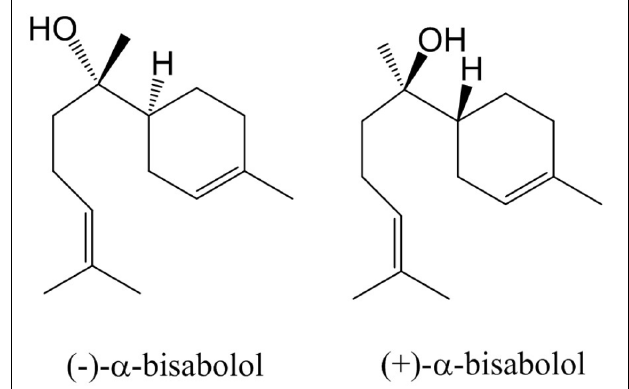
FIGURE 1 | Structures of α -bisabolol